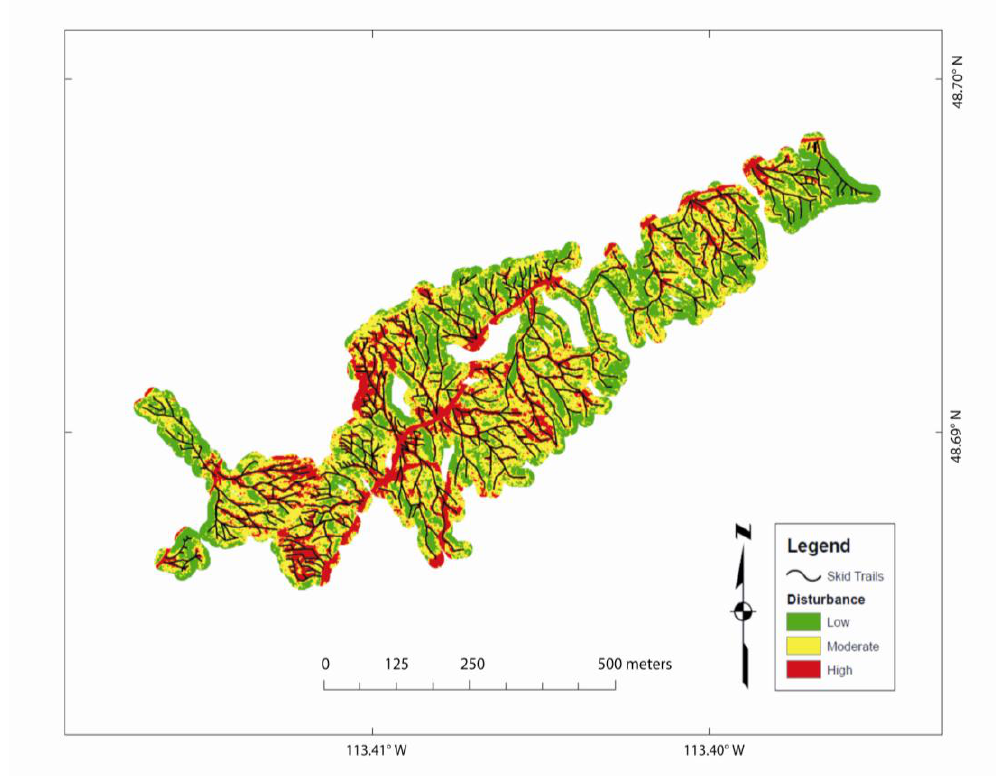
Figure 4. Red Eagle Fire: disturbance classification. The area in green indicates low disturbance (29%), yellow indicates moderate disturbance (44%), and red indicates high disturbance (27%). The area is clipped to a 15-m buffer around the harvest trails (as mapped by GPS tracking devices) and these are shown in